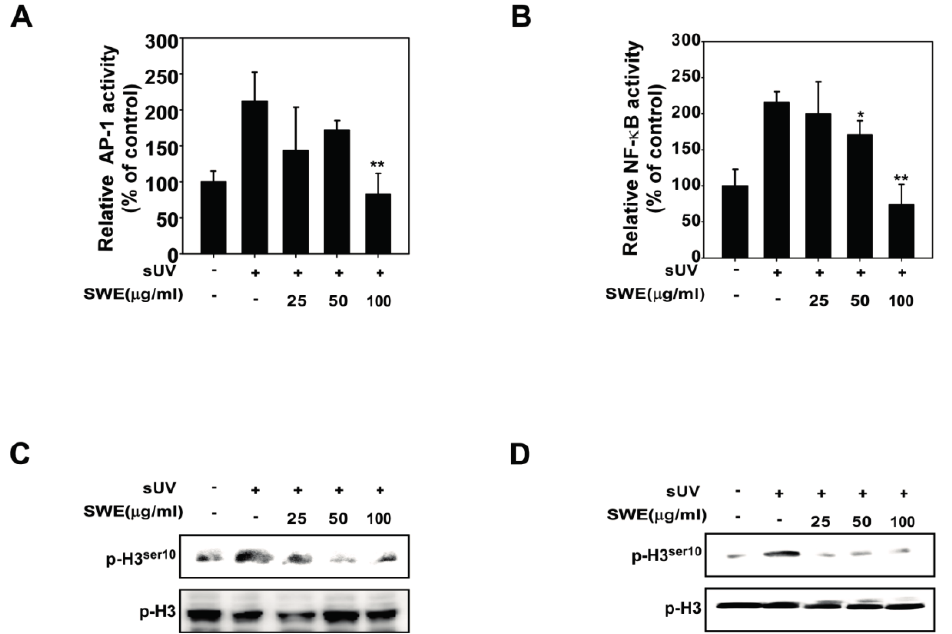
Figure 2. Effects of SWE on sUV-induced AP-1/NF-  B transactivation and histone H3 Phosphorylation. ( A , B ) SWE suppresses sUV-induced AP-1 and NF-  B